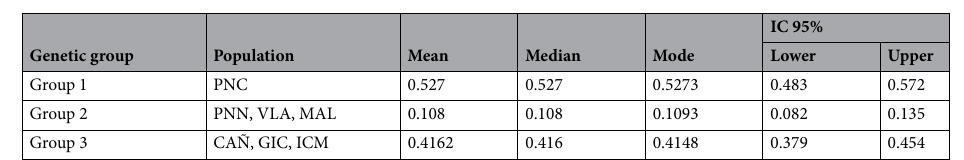
Table 3. Populations belonging to each genetic group. Values of mean, median and mode, Bayesian credibility intervals (Confidence level, 95% of probability) of the F st values for each genetic group ( K = 3).